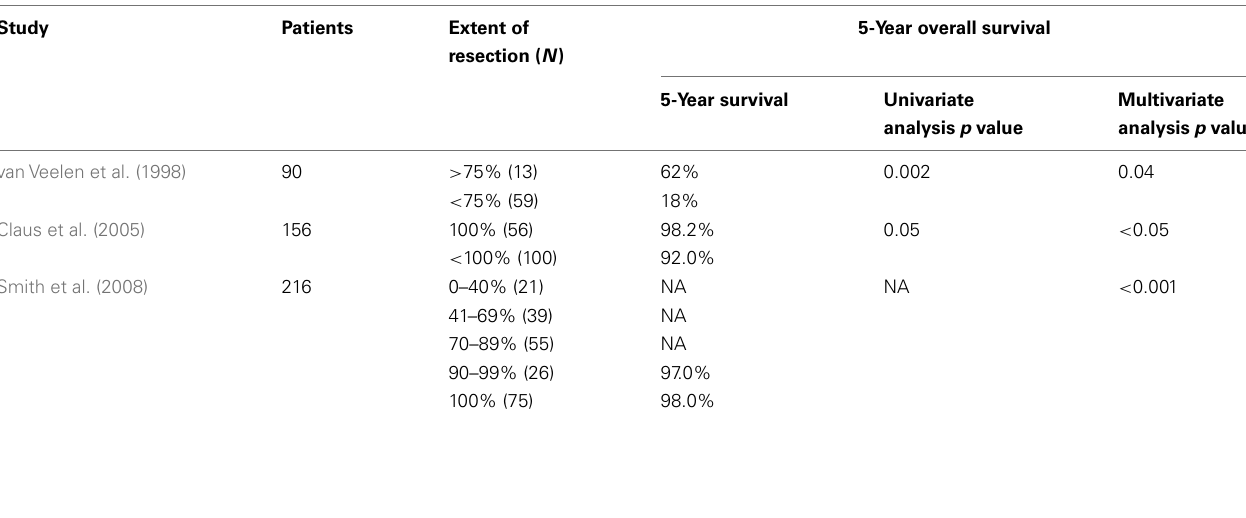
Table 4 |Volumetric EOR studies in low-grade